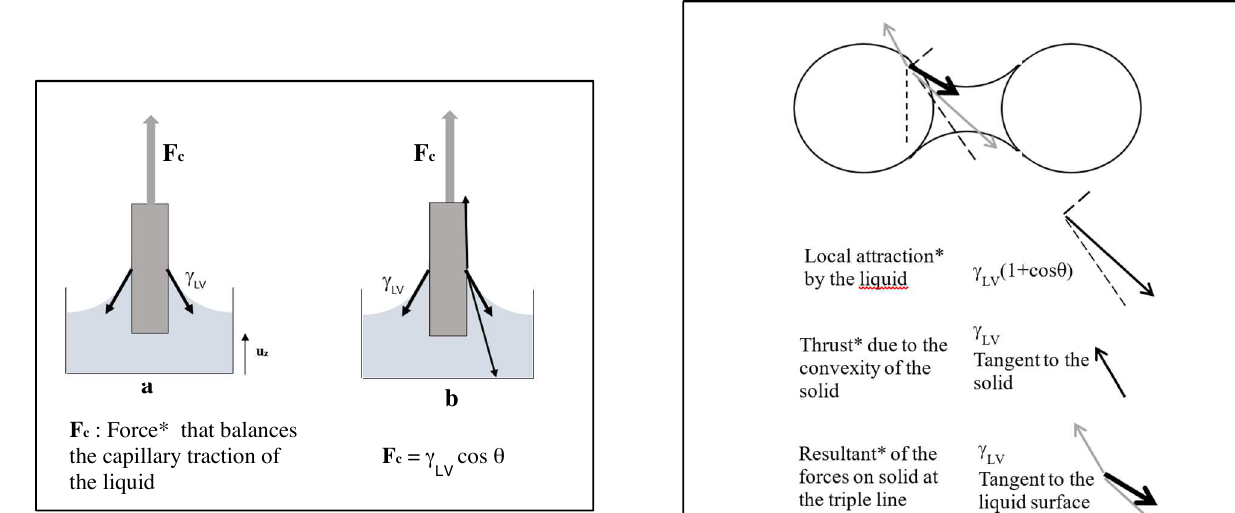
Fig. 6. A very common diagram for the tensiometer (a) and a more detailed account of the forces* at play (b): thin arrow downward: vertical component* of the local attraction (1+ cos θ ) u z ; thin arrow upward: water/glass – γ LV resultant* of the distributed forces due to the convexity of the u z . Both approaches lead to the same immersed body, γ LV correct formula F c = γ cos θ u z . *All “forces” are by unit LV length of triple line.